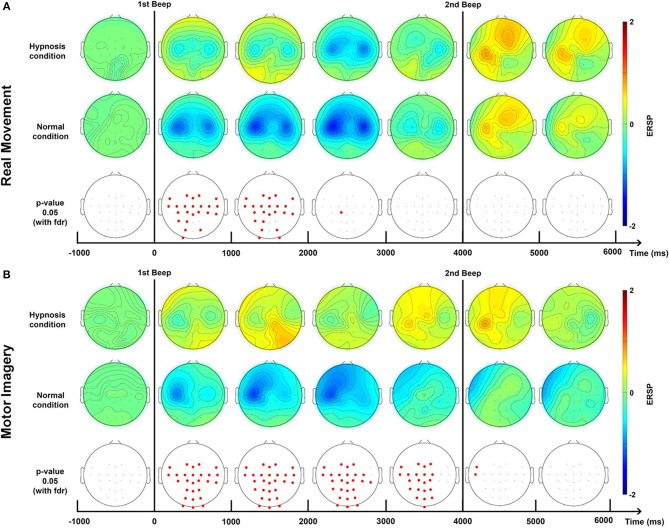
Topographic maps of ERD/ERS% (grand average, n = 23) in the Beta band (15–30 Hz) for a real movement (A) and a motor imagery (B) during two conditions: normal and hypnotic. Red corresponds to a strong ERS and blue to a strong ERD. The first vertical black line indicates when the motor task started and the second one to when it stopped. This figure is an extrapolation of 32 electrodes. Red electrodes indicate a significant difference (p < 0.05) with an FDR correction.